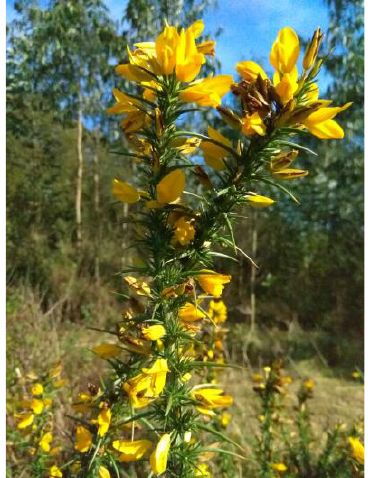
Figure 1. Image of the sample collected and identified as Ulex gallii Planch.